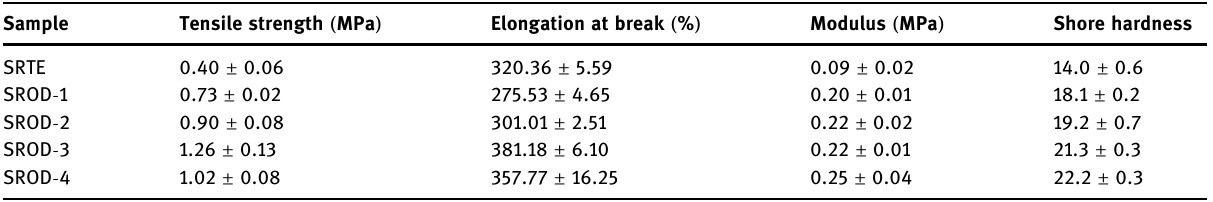
Table 3: Mechanical properties of RTV silicone rubber Sample